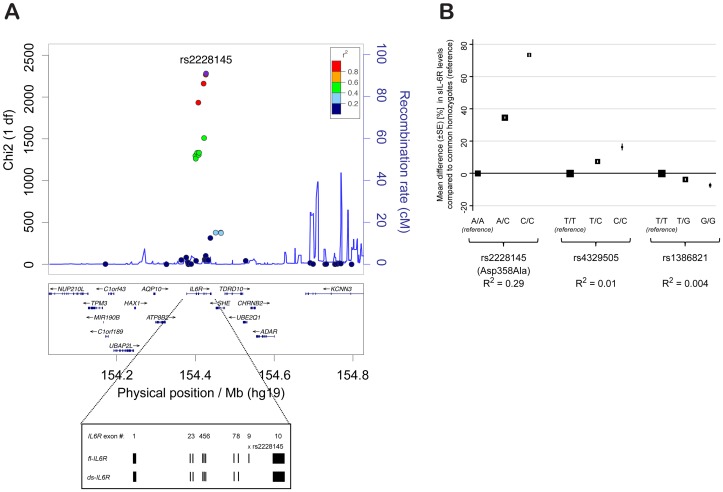
rs2228145 is the major determinant of circulating sIL-6R levels at the IL6R locus.(A) X2 statistics for the association (additive allelic effects model of inheritance; see Methods) of 45 SNPs genotyped using the Illumina ImmunoChip with sIL-6R concentrations are plotted against the physical position of the SNPs on chromosome 1 (hg.19). Recombination rates and linkage disequilibrium (r2) values are based on CEU HapMap. Inset depicts exonic structure of the membrane-bound IL-6R (fl-IL6R) and the differentially spliced soluble isoform (ds-IL6R). (B) Results from a regression model containing all three independent IL6R SNPs. Mean differences in sIL-6R concentration (%) compared to the common homozygote reference groups are plotted for the 3 SNPs independently associated with sIL-6R levels. Box size is proportional to the number of individuals in each group and error bars represent the standard error of the mean. SE = standard error of the mean difference. R2 = variance explained by the individual SNP.